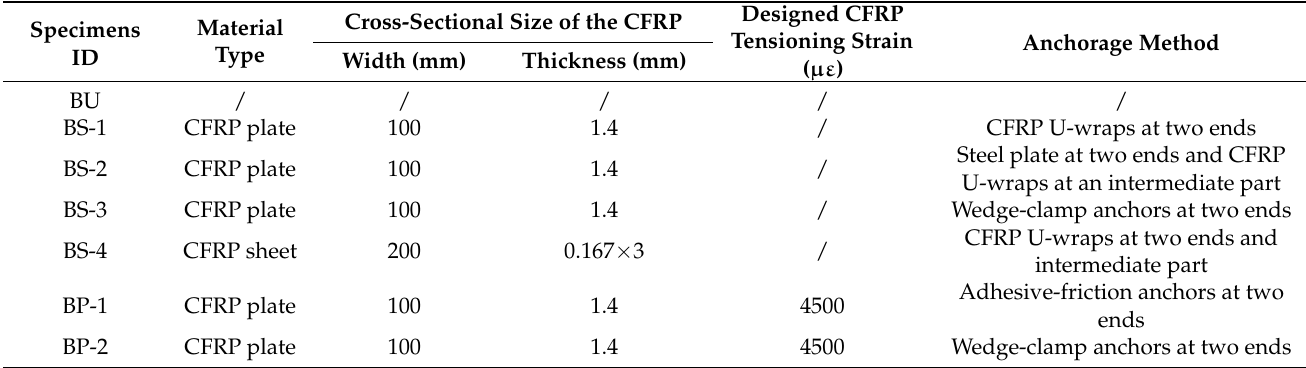
Table 2. Details of the